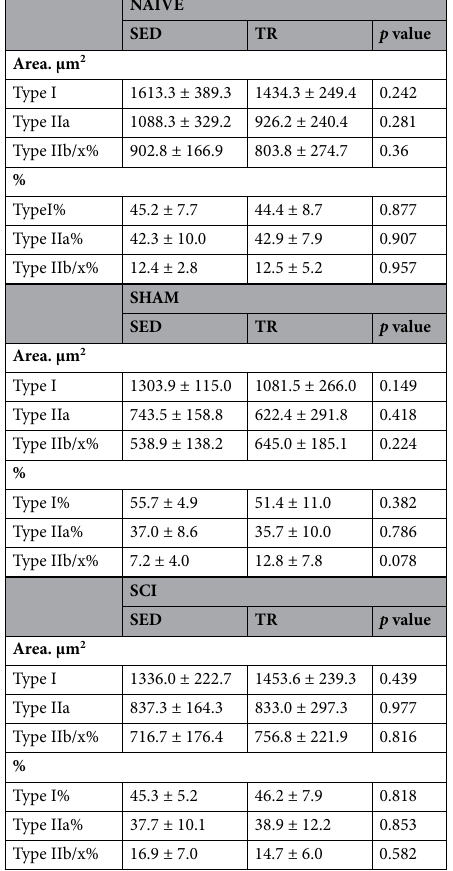
Table 1. Soleus muscle fiber type area and distribution. Values are means ± SD for NAIVE, SHAM and SCI (SED and